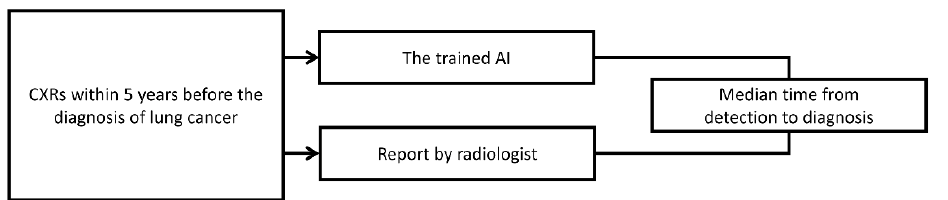
Figure 7. Study design of the model validation on a temporal scale.